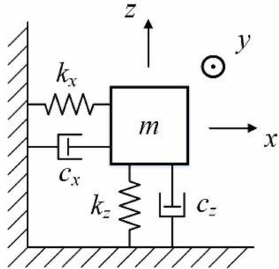
Figure 1. The model of ideal gyroscope.